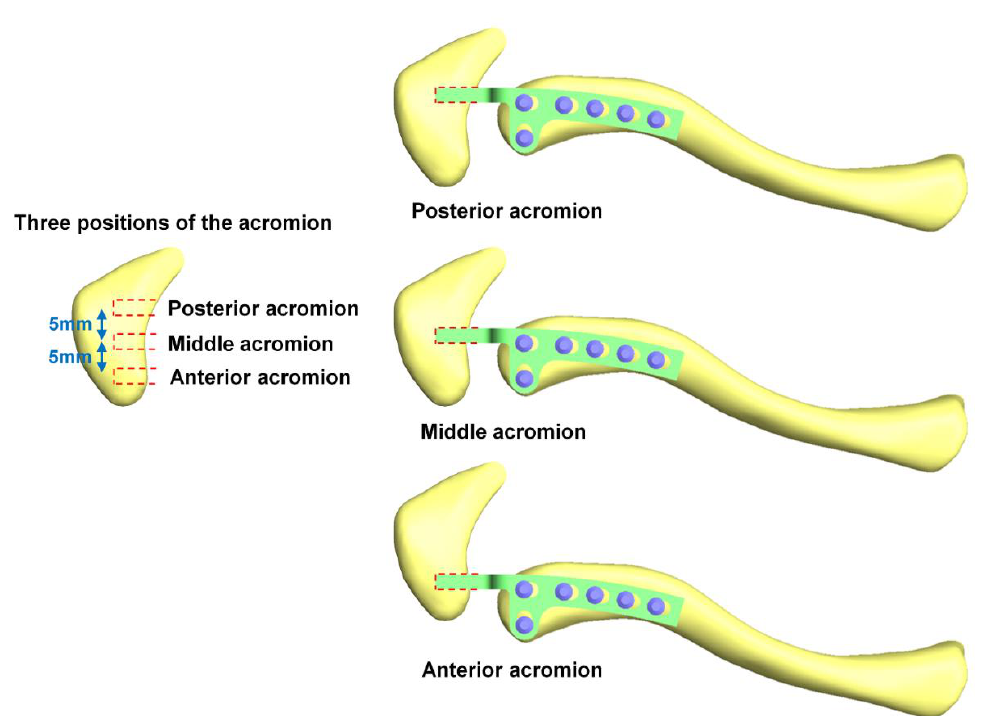
Figure 3. The hooks were fixed at the anterior, middle, and posterior of the acromion at an interval of 5 mm.